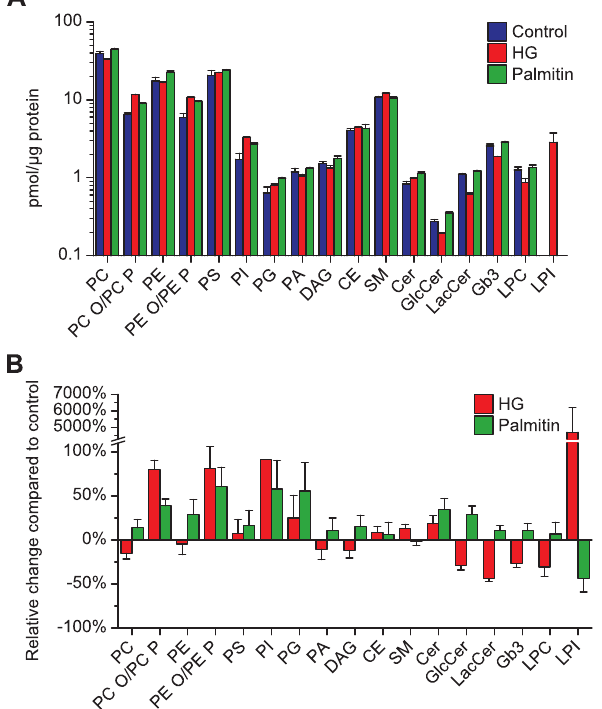
Figure 2. Overall changes in the lipidome of HEp-2 cells after treatment with HG or palmitin. HEp-2 cells were treated for 24 hours with HG (20 m M), palmitin (20 m M) or ethanol (0.1%, as control) before analyzing the lipidome by MS. ( A ) The total amount of the different lipid classes are shown as absolute values (note the logarithmic scale) and ( B ) the difference between treated cells and control cells are expressed as relative values.